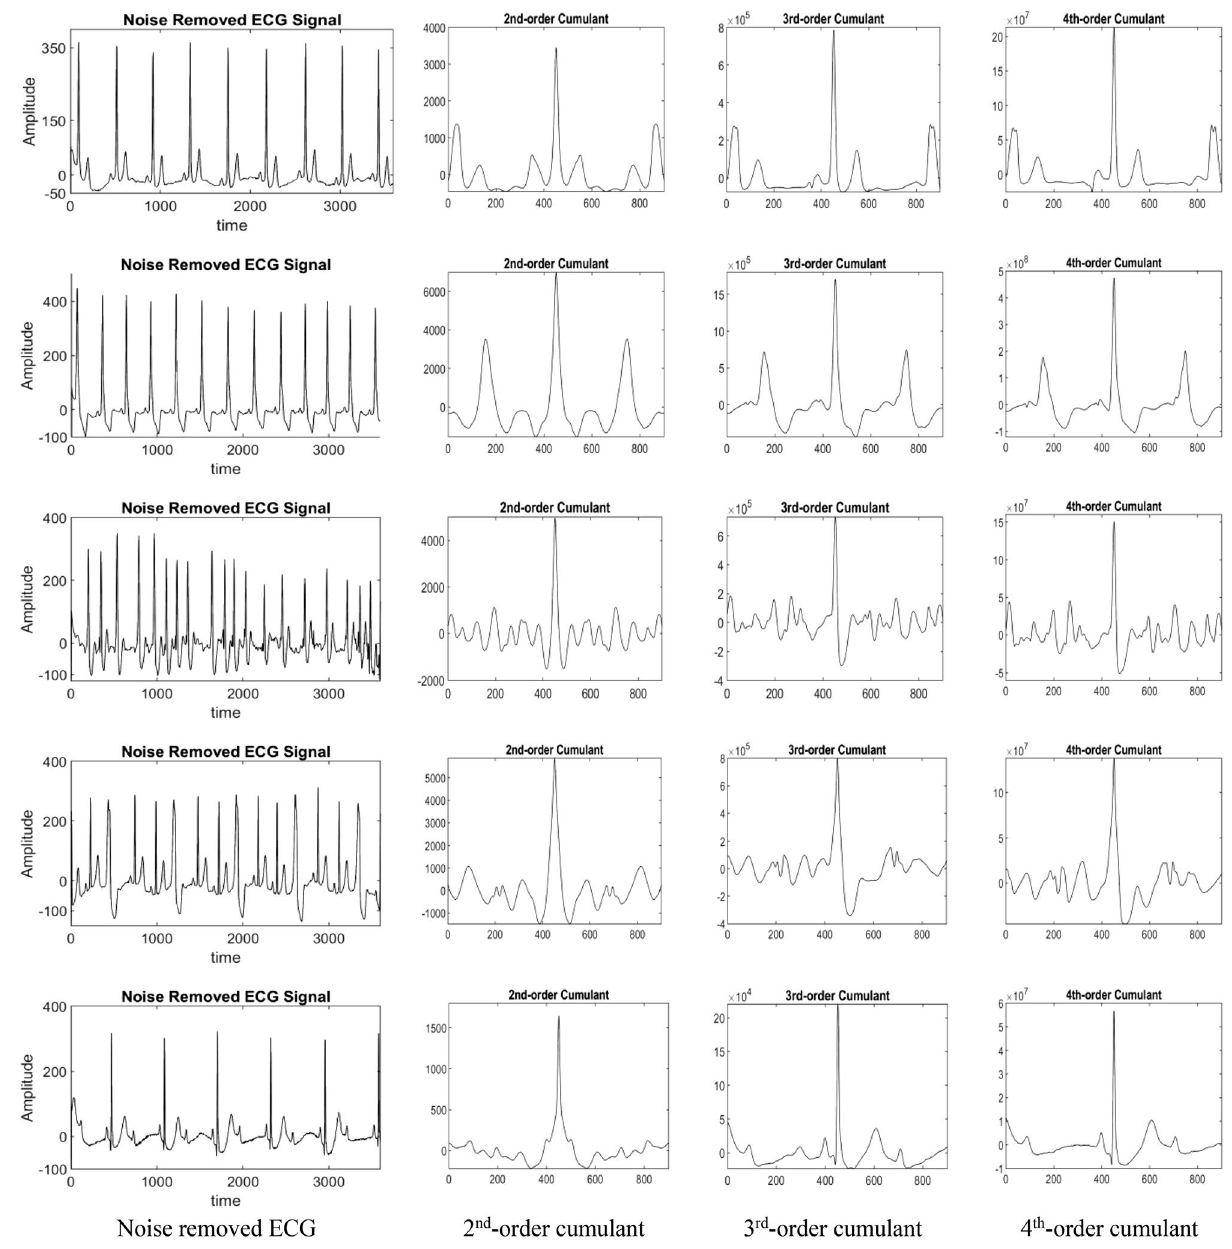
Figure 13. Noise removed ECG and corresponding 2nd-, 3rd- and 4th-order